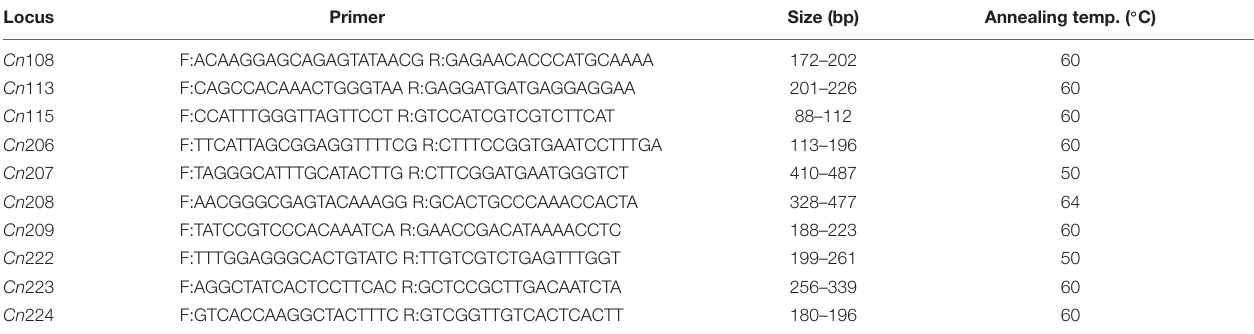
TABLE 1 | Characteristics of Chlamys nobilis microsatellite loci used in this